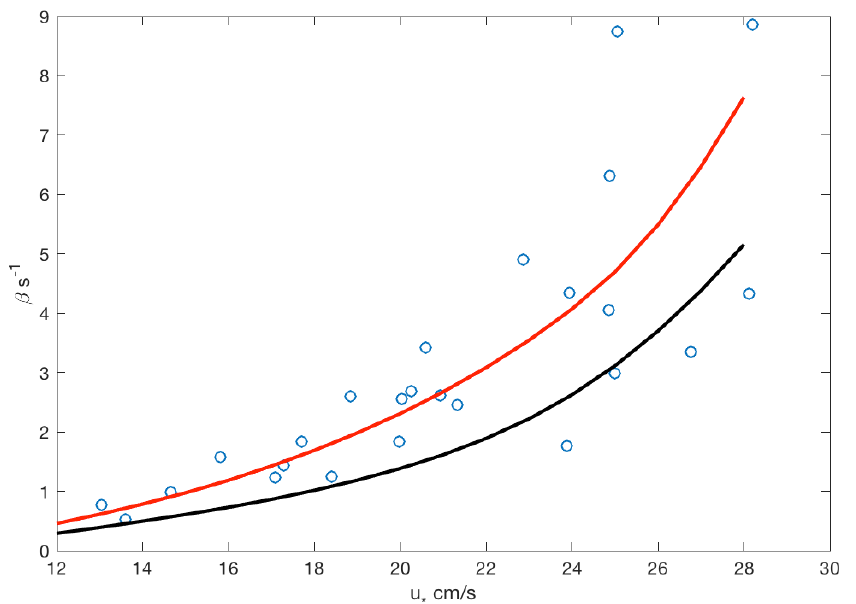
Figure 5. Colour online. Comparison with experimental data. The energy growth rate β is plotted against the friction velocity u ∗ . ◦ [4] experimental results realized with u ∗ z 1 / ν a = 5, with z 1 the height of the viscous layer in the air. Red: Theoretical values obtained using the van Driest velocity- profile in the air and the exponential profile in the water. Black: Theoretical values obtained using the lin-log velocity profile in the air and the exponential profile in the